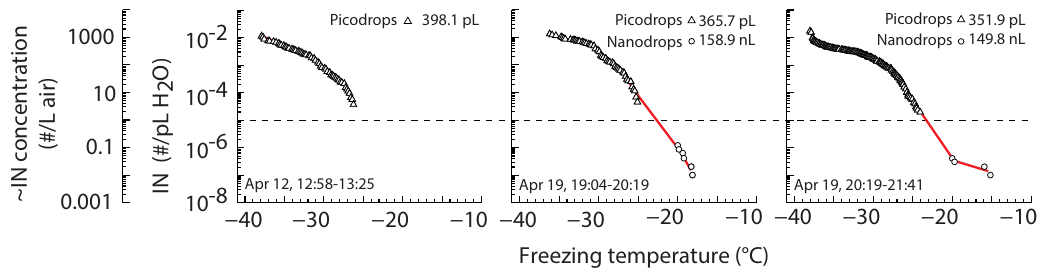
Figure 9. The primary y axis gives the number of ice nuclei per picolitre of water measured in precipitation samples. The secondary y axis roughly approximates IN concentrations per litre of air, assuming that 1pL ∼ 1 cloud droplet and a cloud droplet number concentration of 100cm − 3 . The label on the bottom left of the plot indicates the date and time during which the sample was collected. The horizontal dashed line corresponds to IN concentrations of 1L − 1 and is added to guide the